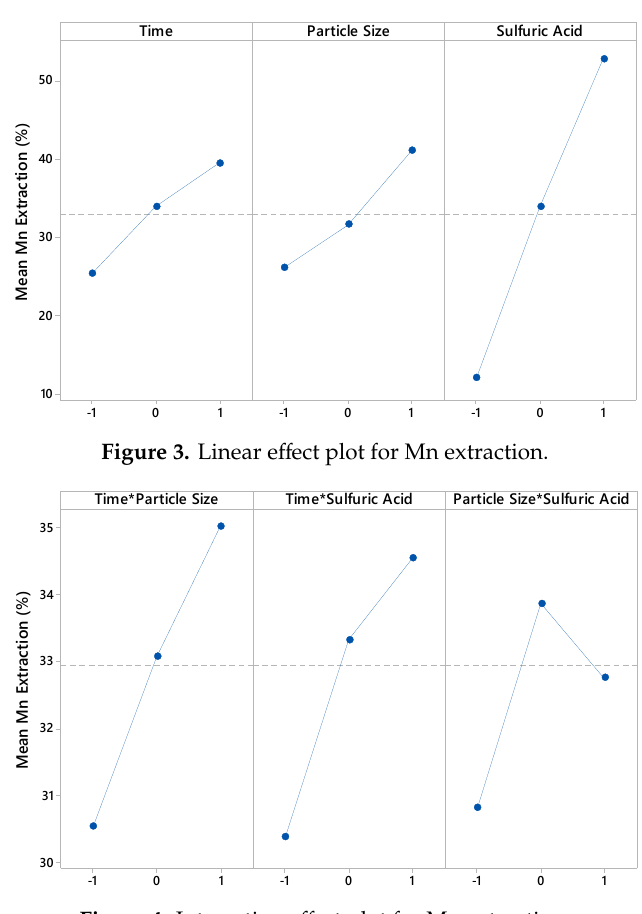
Figure 4. Interaction e ff ect plot for Mn Figure 2. Interaction effect plot for Mn extraction. Figure 2. Interaction effect plot for Mn extraction. Figure 2. Interaction effect plot for Mn extraction.